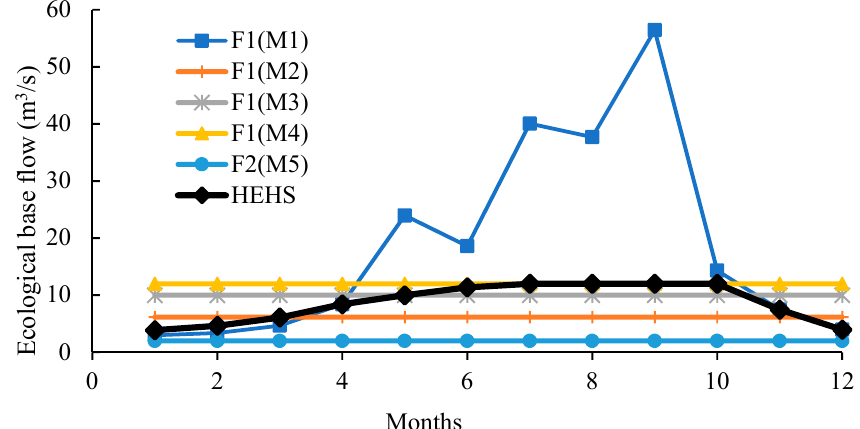
Figure 2. Establishment of the healthy eco-hydrological sequence of rivers based on response relationship of hydrological process and ecological functions of river ecological base flow. Notes: F1(M1) refers to the water requirement of the ecological function of protecting from drying-up rivers (F1) calculated by Tennant (M1), and also, F1(M2), F2(M3), F3(M4), F3(M5) are similar to F1(M1), F1, F2, F3, M1, M2, M3, M4, M5 as shown in Table 1. HEHS refers to the water requirement of the healthy eco-hydrological sequence of rivers.